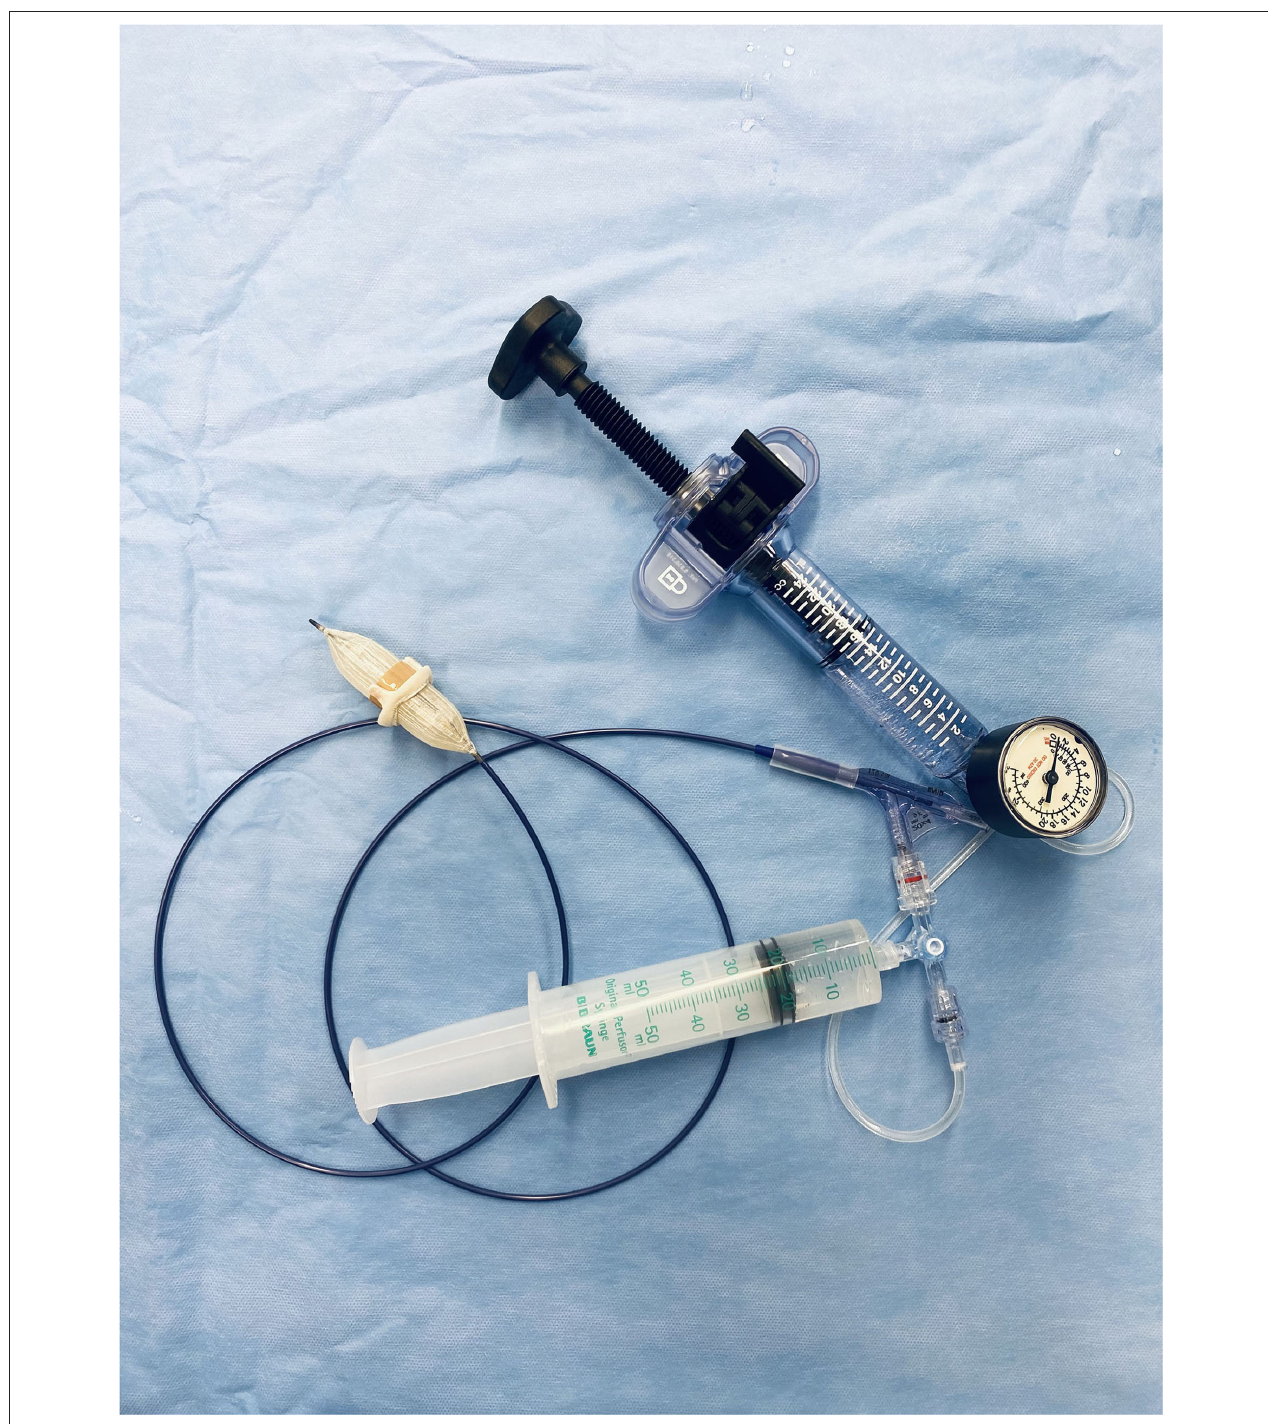
FIGURE 1 | In-vitro test setting with a high-pressure balloon connected via high-pressure stopcock to a 50-ml syringe containing dilute contrast and to a high-pressure